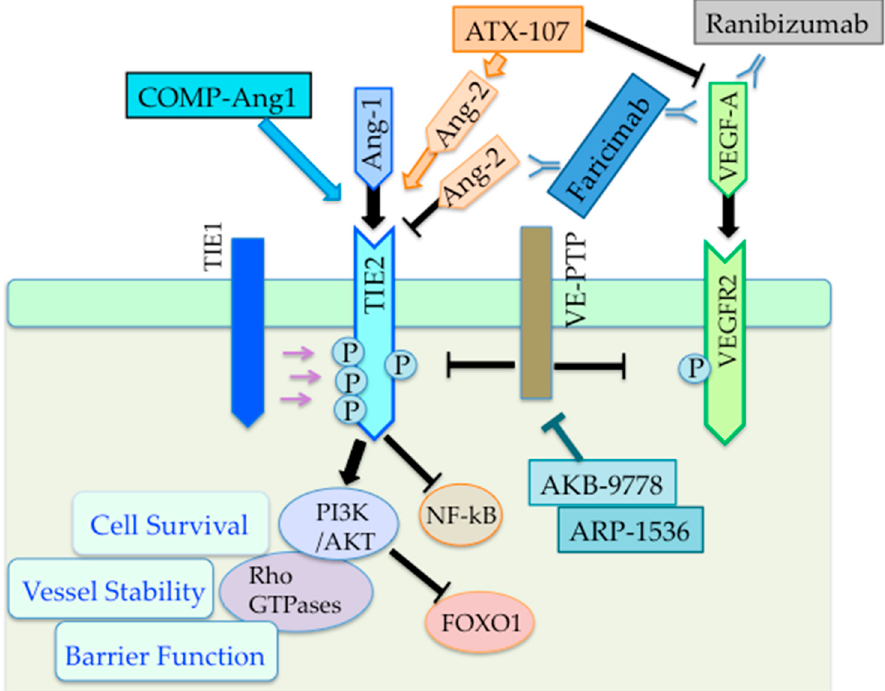
Figure 3. Ang-TIE therapeutics against diabetic retinal diseases. The schema indicates possible Ang- TIE targeting drugs for diabetic retinal diseases and their signaling targets in ECs. Faricimab, a bispecific antibody that targets both Ang2 and VEGF-A, is in phase 3 clinical trials for diabetic retinal diseases, such as diabetic macular edema (DME). VE-PTP inhibitors, ARP-1536 and AKB-9778, which can activate the Ang1-TIE2 pathway, are under clinical development for DME. In addition, VE-PTP inhibition by those drugs deactivate VEGFR2. In a phase 2a clinical trial, AKB-9778 with ranibizumab, a recombinant VEGF-A antibody, resulted in significant reduction in DME. A collagen IV-derived peptide, ATX107, is under clinical development. ATX107 uniquely converted Ang2 into a TIE2 agonist, and thereby activating TIE2 signaling in experimental models. ATX107 also inhibited VEGF signaling. In experimental models of diabetes, soluble Ang1 variant, COMP-Ang1, protected retinal vascular structure, blood retinal barrier integrity, and visual